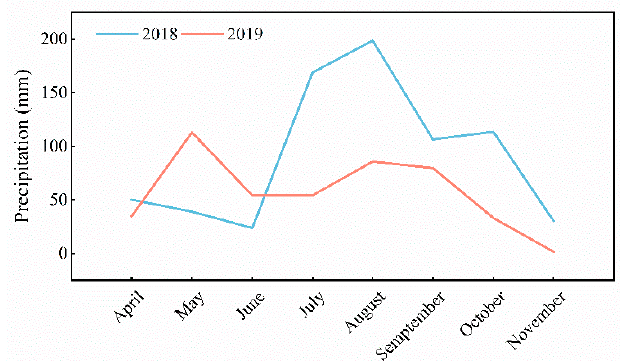
Figure 6. Average monthly precipitation (mm) of the experimental site during the summer in 2018 and in 2019. and in